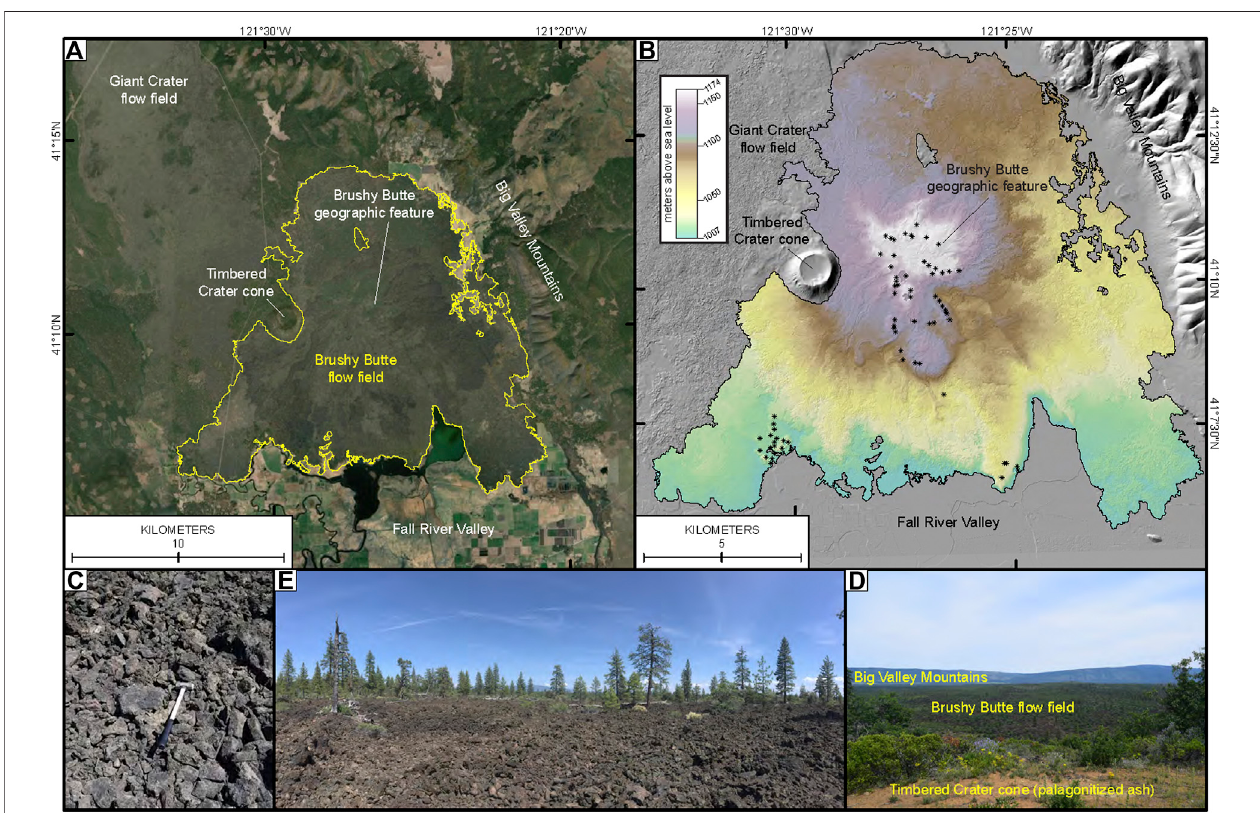
FIGURE2|(A) SatelliteimageryshowingtheyouthfulappearanceoftheBrushyButte(withtheBrushyButtegeographicfeaturenoted)andGiantCrater fl ow fi elds. (B) 1 m-resolution lidar derived hillshade and colored DEM showing the topographic roughness of the Brushy Butte fl ow fi eld. * symbols denote the locations of vents, such as scoria cones, spatter cones, and craters, of which multiple effusion points are common for tholeiitic basalt eruptions. (C) View of sparsely vegetated, young- looking slabby p (cid:1) ahoehoe lava fl ow from the Brushy Butte fl ow fi eld. The horizontal fl at lava plates are ideal for 36 Cl cosmogenic surface-exposure dating. Photograph was taken at 41.15528 N, 121.51449 W. (D) View looking east into the morphologically rough, sparsely vegetated surface of the Brushy Butte fl ow fi eld. Photograph was taken at 41.14666 N, 121.50854 W. (E) View looking east from the top of the Timbered Crater cone (reddish-tan palagonitized ash in the foreground) looking at the low-lying Brushy Butte fl ow fi eld and the high-standing Big Valley Mountains. Photograph was taken at 41.17164 N, 121.48444